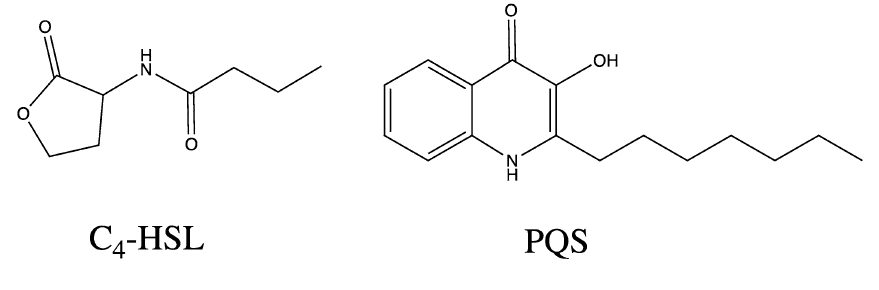
Figure 1. Molecular structures of C 4 -HSL and